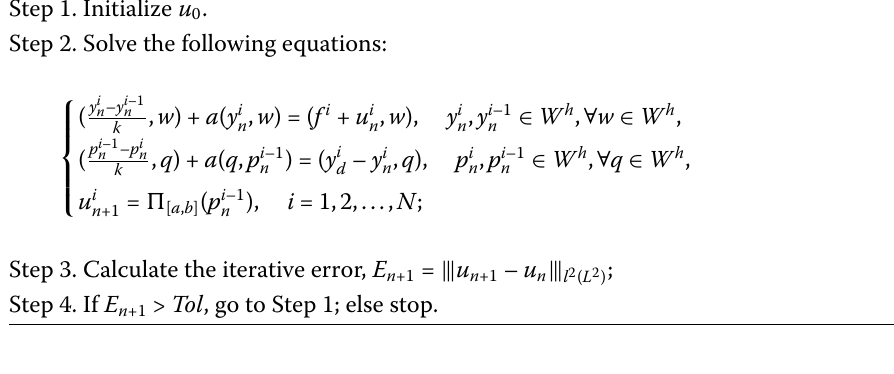
Algorithm 5.2 Adaptive VD approximation